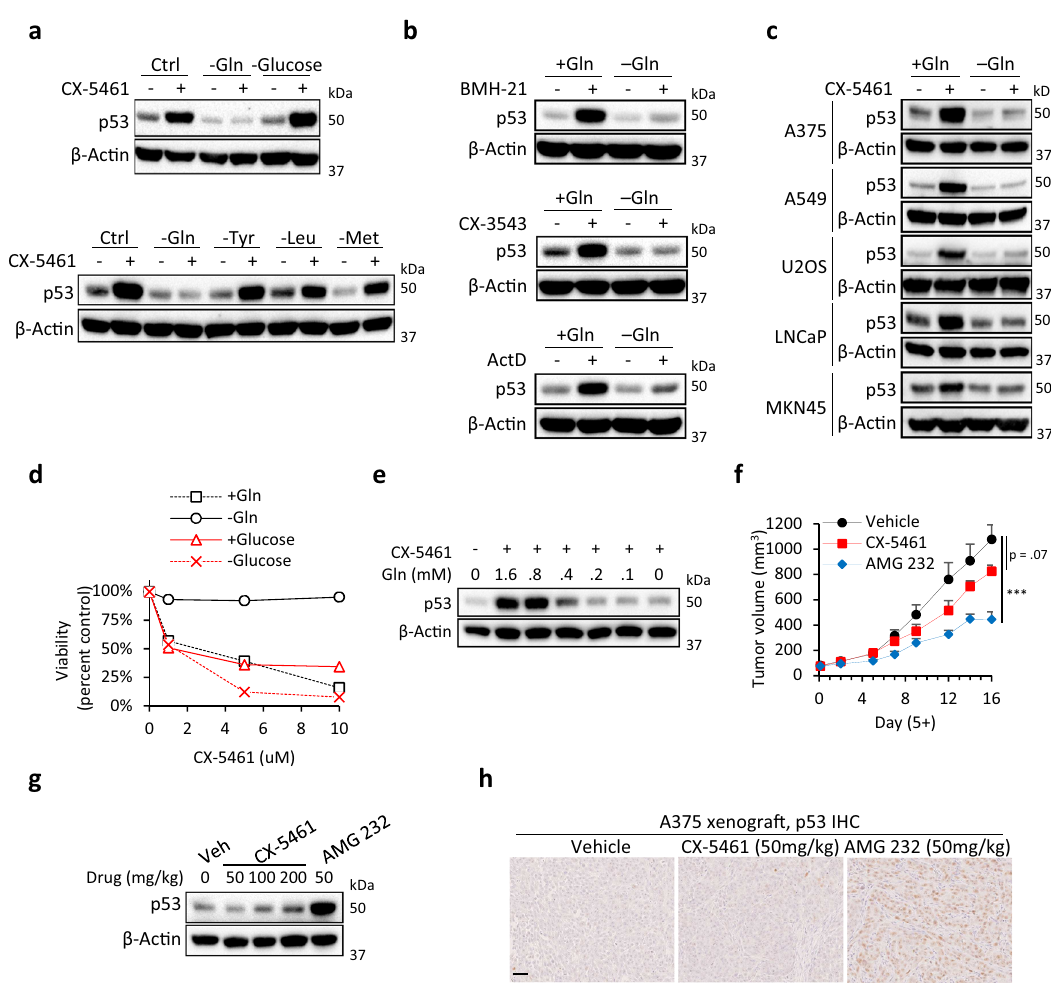
Fig. 6 Glutamine deprivation confers cancer cells resistance to RNA Pol I inhibitors by blocking the nucleolar surveillance pathway. a Glutamine deprivation inhibits the activation of p53 by CX-5461 treatment. HCT116 cells were cultured in the respective starvation medium for 16 h followed by CX- 5461 (1 µ M) for 8 h. b Glutamine deprivation inhibits p53 activation by BMH-21 (1 µ M), CX-3543 (1 µ M), and ActD as assessed by western blotting. c Glutamine deprivation inhibits p53 activation by CX-5461 (1 µ M) in A375, A549, U2OS, LNCaP, and MKN45 cells. d Deprivation of glutamine but not glucose conferred resistance to CX-5461 (1 µ M) as assessed using MTT assay. Data points of each treatment were normalized to the respective vehicle- treated metabolic control. Data represent mean ± SD of n = 6 biological replicates. e p53 activation by CX-5461 was suppressed under 0.4 mM glutamine as assessed by western blotting. f CX-5461 failed to inhibit HCT116 tumor growth. Mice were orally dosed with vehicle (NaH2PO4), CX-5461 (50 mg/kg), or AMG 232 (50 mg/kg) once daily three times per week. Drug treatment started 5 days post implantation on tumors of approximately 75 mm 3 . Data represent mean ± SEM of n = 8 mice/group. P values: Vehicle/CX-5461, 0.078, Vehicle/AMG 232, 2.4 × 10 − 4 ( ∗ p < 0.05; ∗∗ p < 0.01; ∗∗∗ p < 0.001). g CX- 5461 does not acutely stabilize p53 in HCT116 tumors. Mice were IP injected with vehicle (NaH2PO4), CX-5461 (50, 100, 200 mg/kg), or AMG 232 (50 mg/kg) and tumors were harvested after 8 h for western blot analysis. (h) p53 IHC staining in A375 tumors following vehicle or drug IP administration. Scale bar represents 50 µ